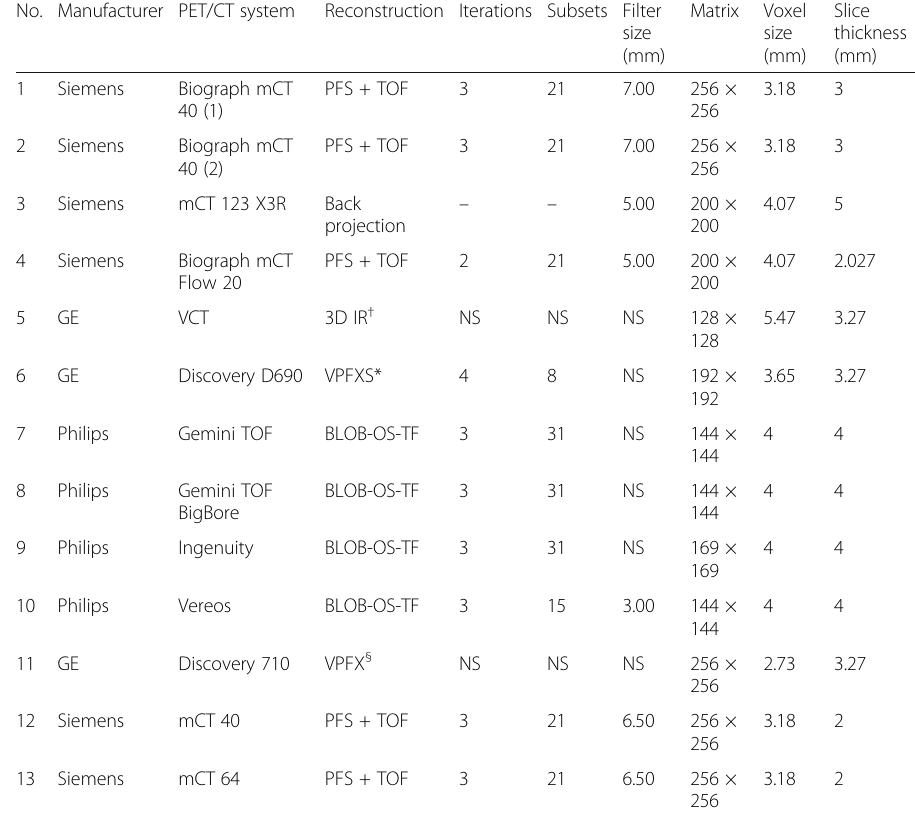
Table 2 PET/CT reconstruction settings for phantom measurements No. Manufacturer PET/CT system Reconstruction Iterations Subsets Filter